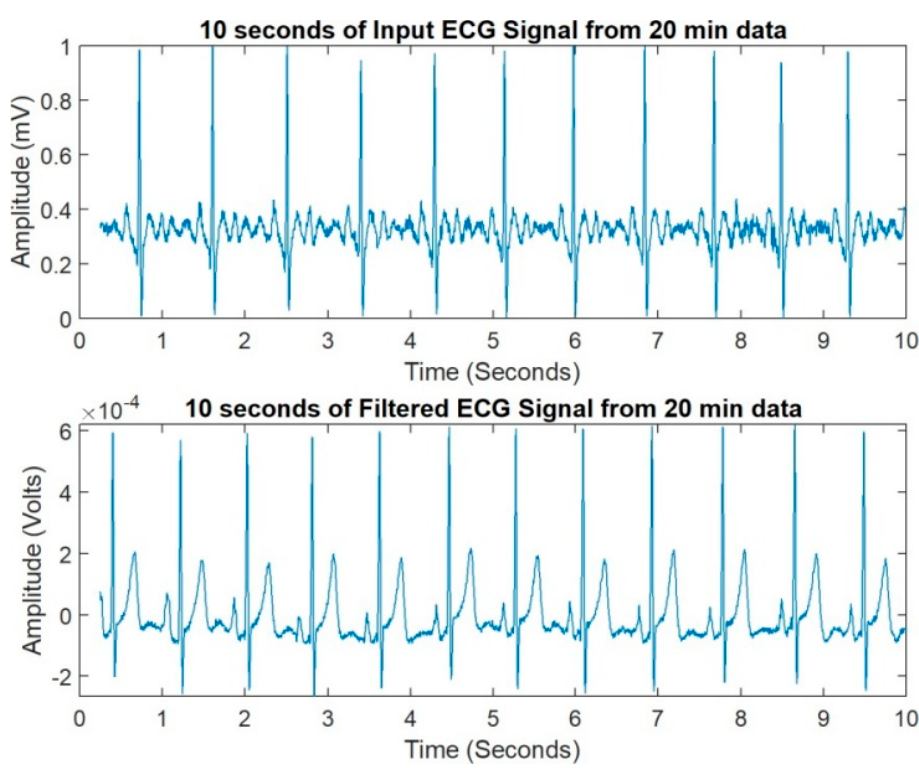
Figure 2. Raw ECG and filtered ECG signal of normal subject for 10 s.